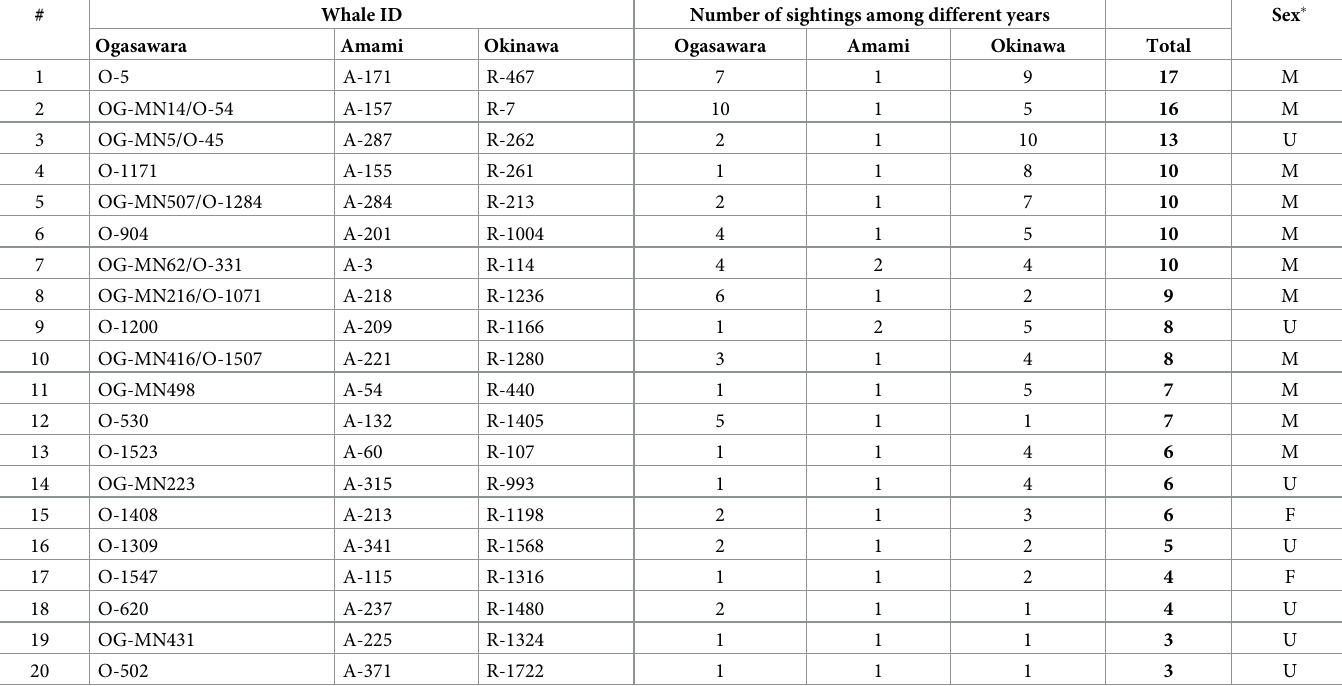
Table 3. Number of sightings of humpback whales which were observed in three different sighting areas (Ogasawara, Amami, and Okinawa) in the different years.